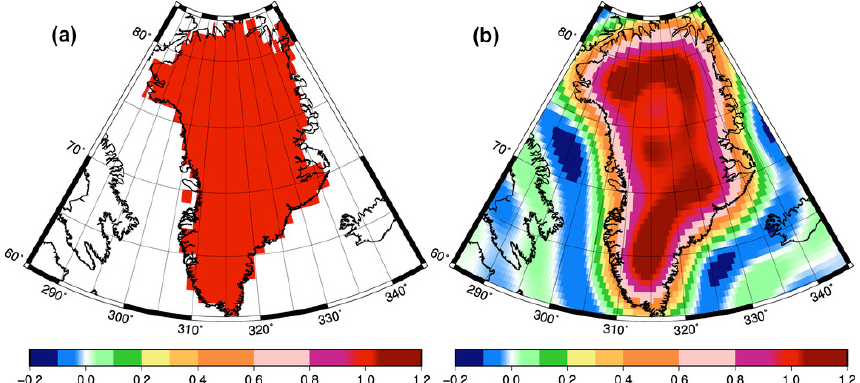
Figure 10. The Greenland weighting kernel (a) and its degree-and-order 60 smoothed version (b) , used when calculating the whole-ice-sheet mass trends shown in Fig. 11. The colors indicate the relative weights applied to various regions of the ice